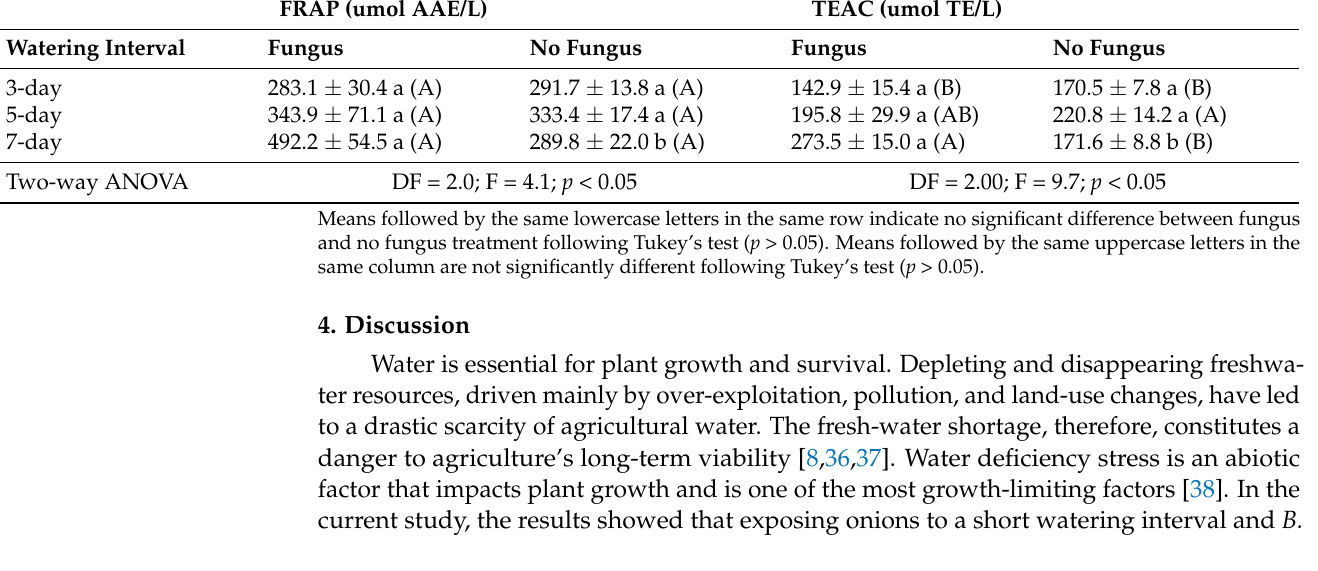
Table 5. The effects of B. bassiana inoculation and watering intervals on the antioxidant capacity of A. cepa . FRAP (umol AAE/L) TEAC (umol